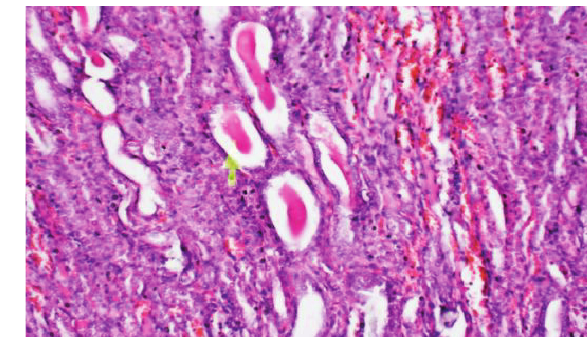
Fig-2C: Tubular damage, casts and haemorrhage (group 2) under 20x (yellow pointer)